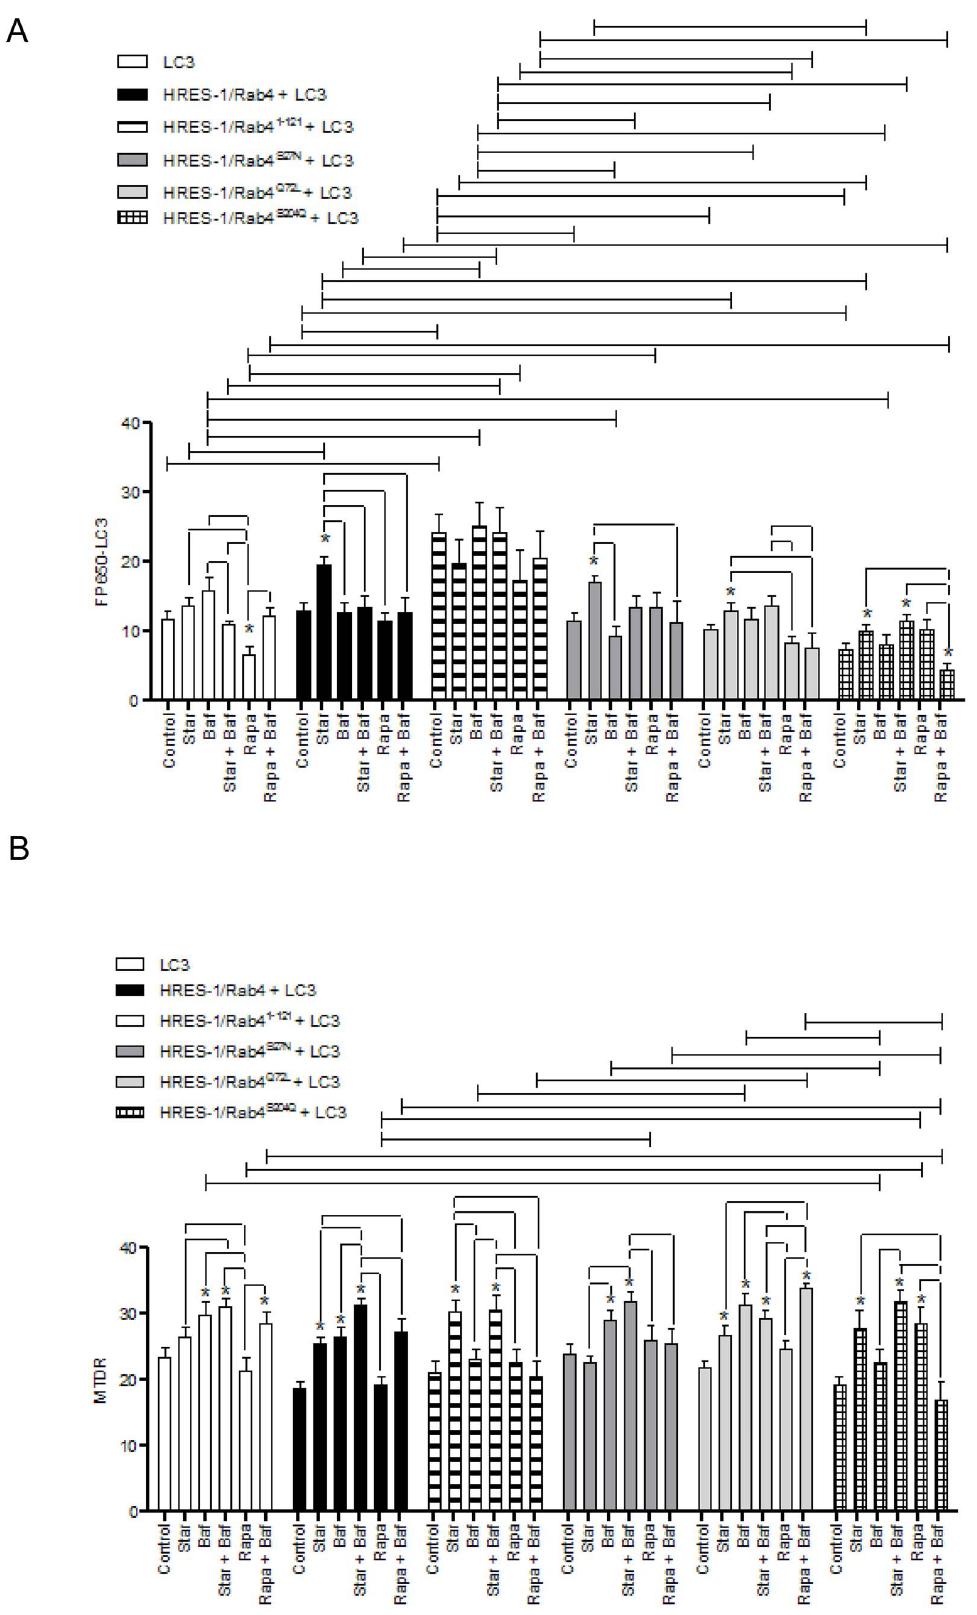
Figure 7. Quantitative analyses of the effect by HRES-1/Rab4 on the accumulation of LC3 + autophagosomes (panel A) and MTDR- stained mitochondria (panel B). HeLa cells were transfected with eGFP-tagged HRES-1/Rab4 isoforms and FP650-LC3. Autophagy was induced by